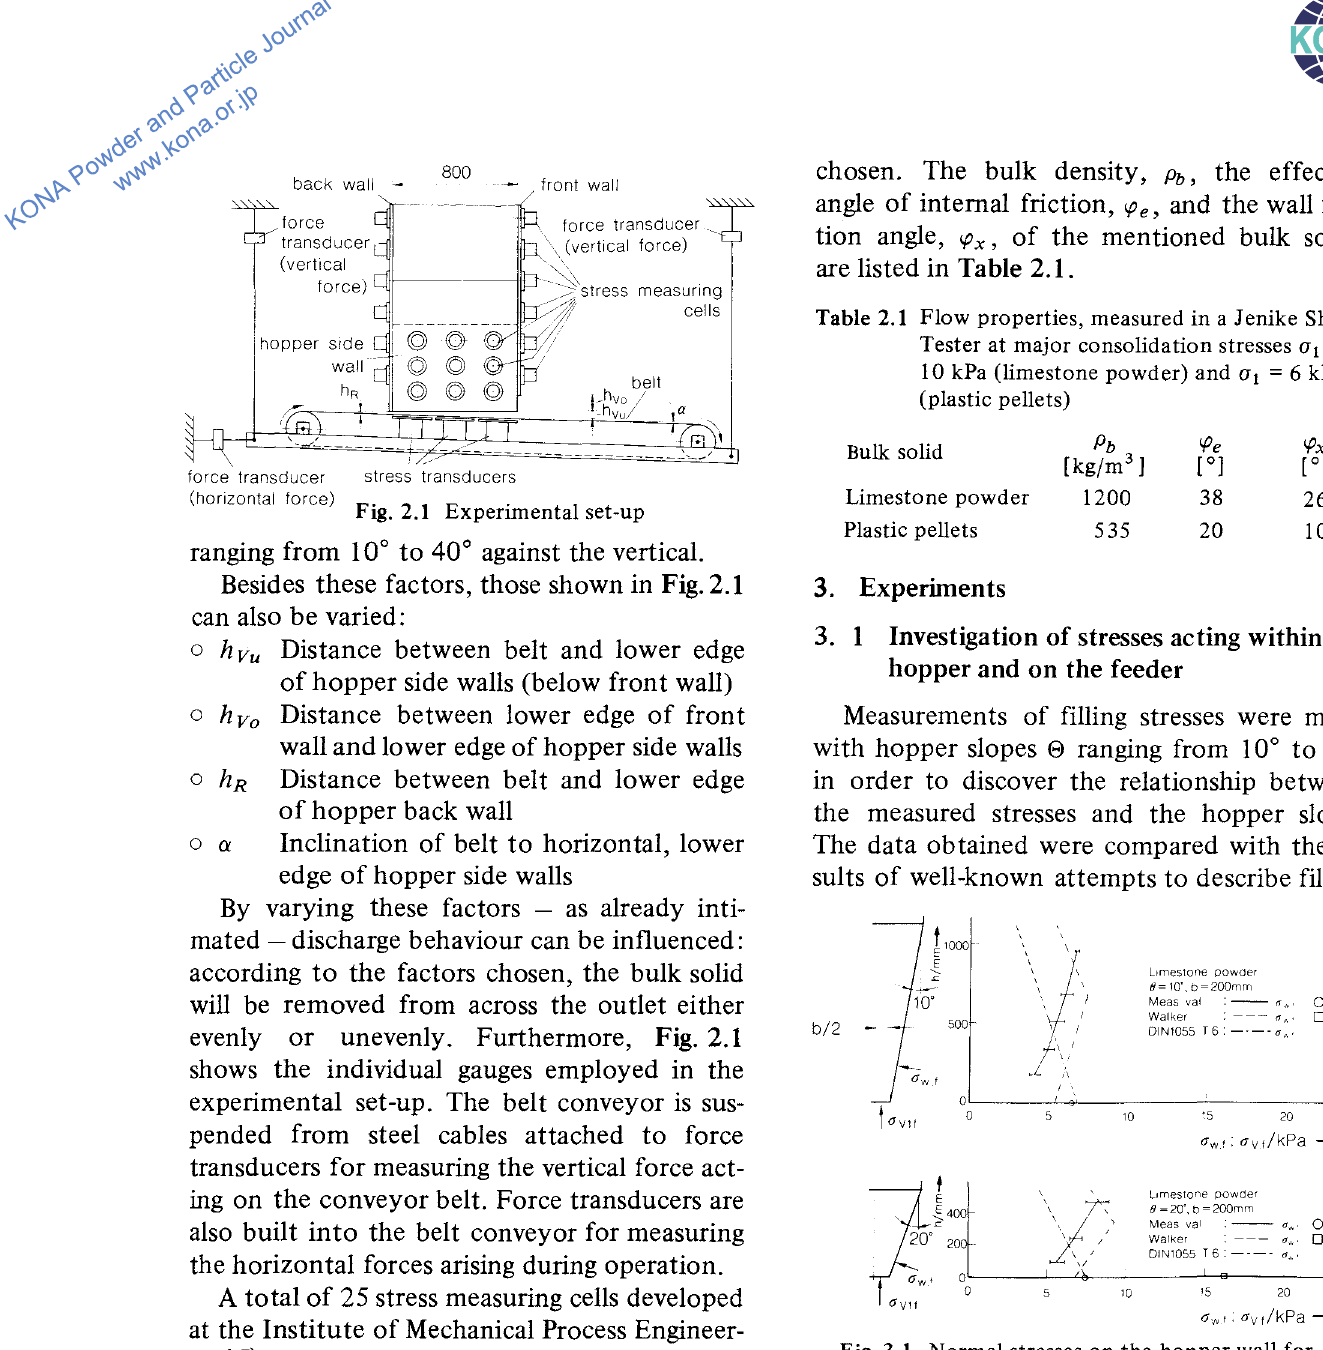
Fig. 3.1 Normal stresses on the hopper wall for e = e = 10° and 20° (limestone powder) stresses in silos. In Fig. 3.1 for the examples e = I Oo and e = 20°, the measured pattern of nor mal stress on the hopper wall, as well as the vertical stress at the level of the outlet are shown. In addition, the stress patterns obtained from the well known analytical models of Walker 8 > and Walters 9 > and from the DIN 1055, Part 6 equations 10 ), which are based on empiri cal relationships, are shown. According to Walker and Walters, there is a certain hopper slope e, which in the case under